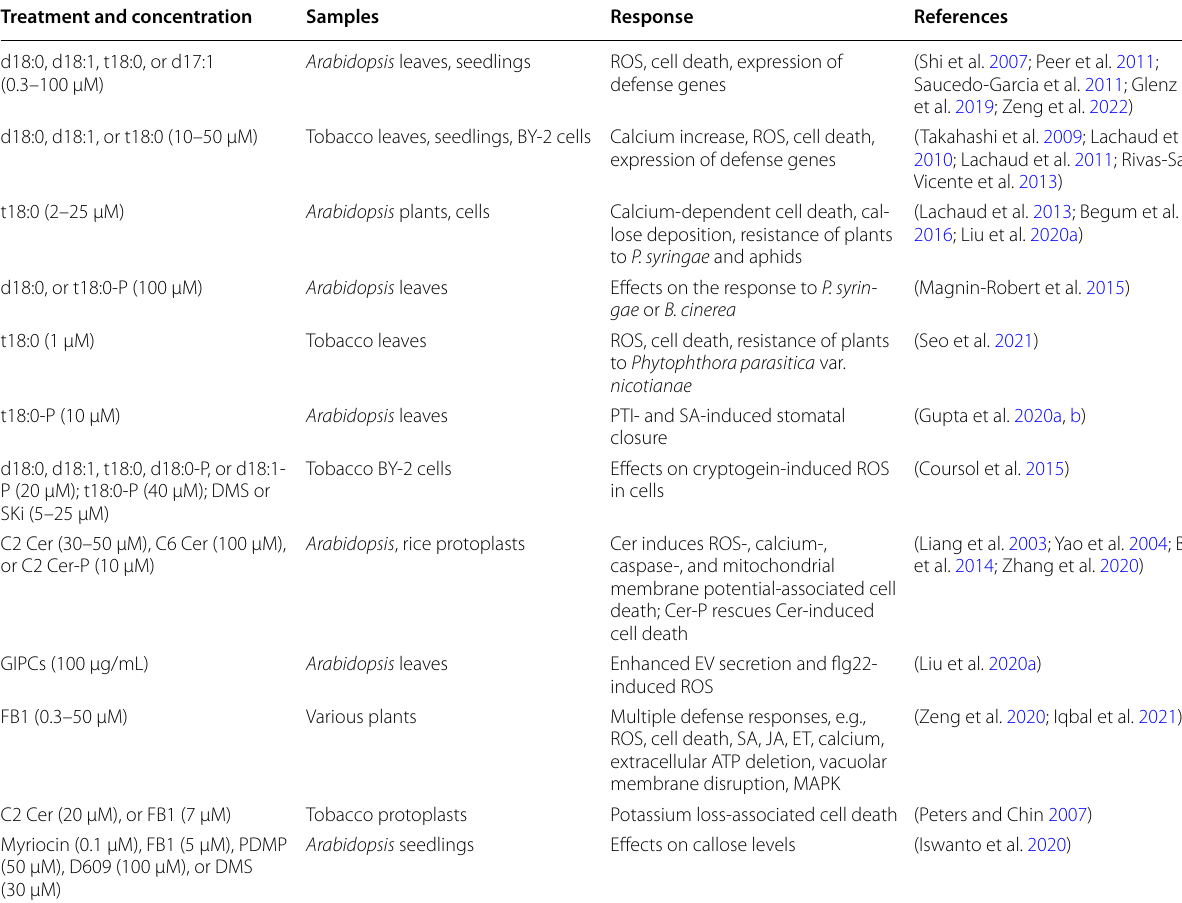
Table 2 Exogenous treatments of sphingolipids or sphingolipid metabolism inhibitors affecting plant cell death and immunity